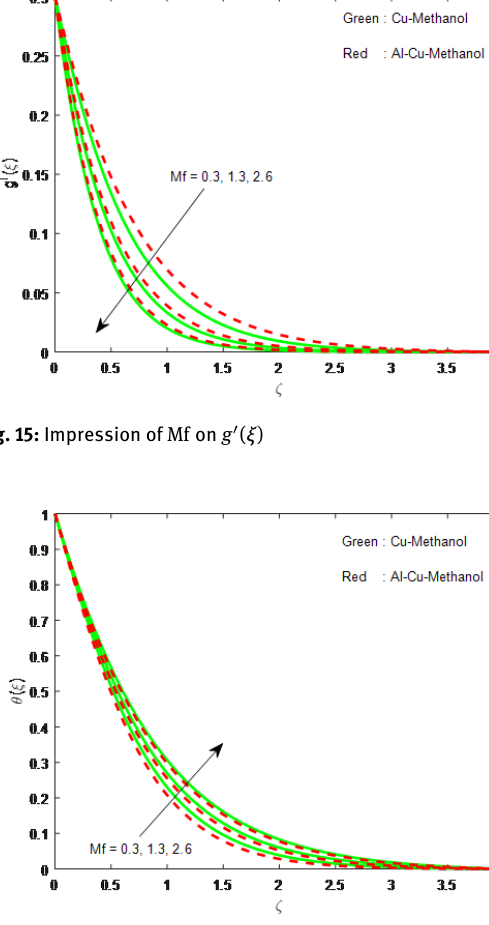
Fig. 13: Impression of Λ on θ ( ξ )